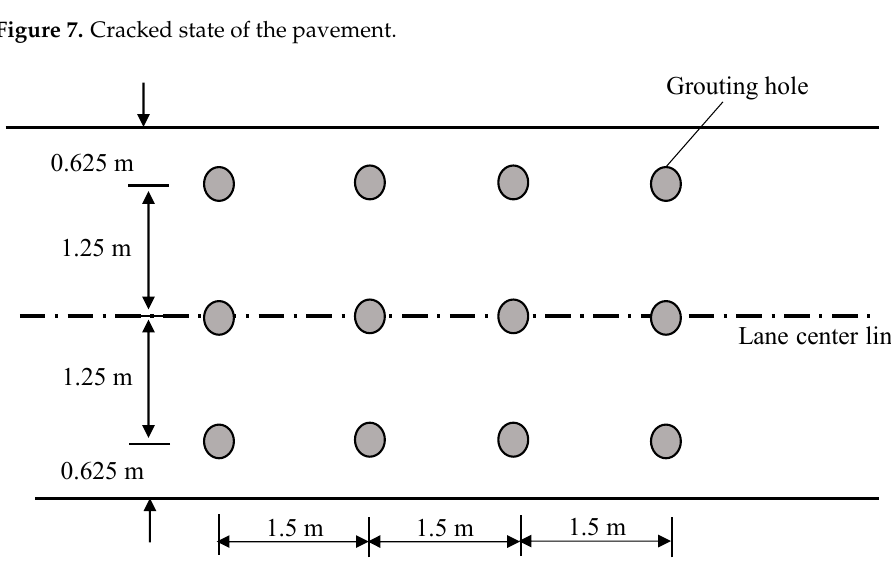
Figure 8. Schematic diagram of grouting design.